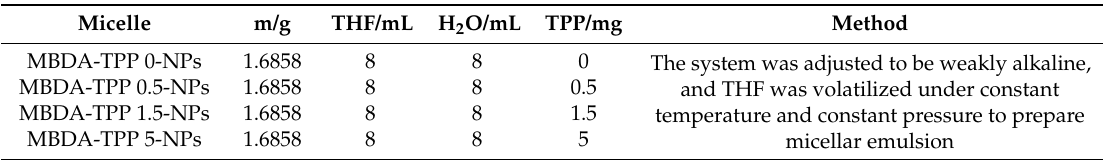
Table 1. The composition of the Micellar emulsion.